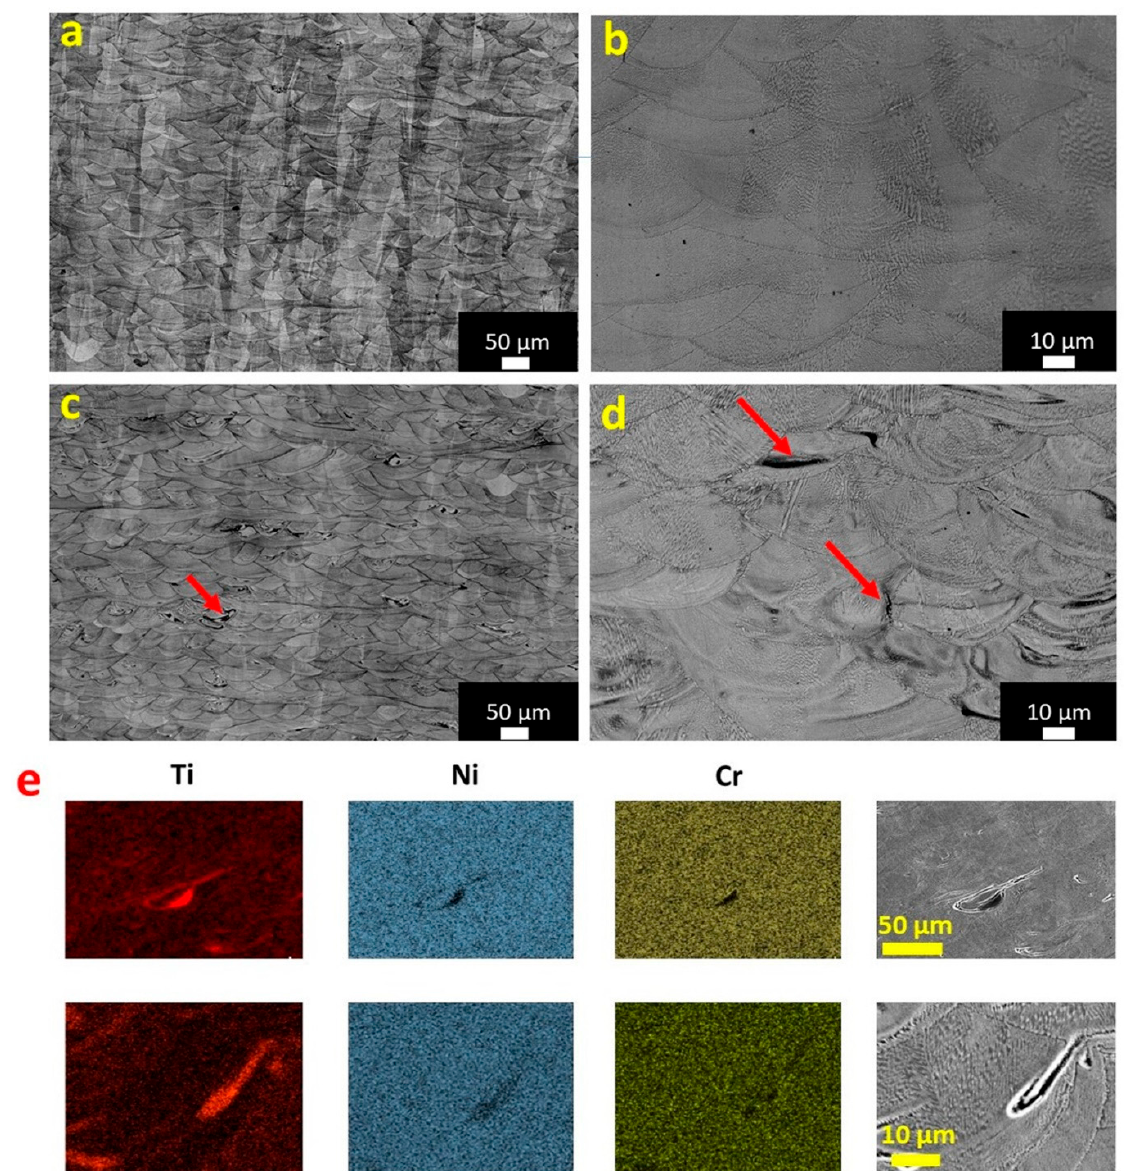
Figure 3. LOM images of the AB IN625 ( a , b ) and AB IN625mod ( c , d ). Presence of residual Ti-rich segregations (indicated by the red arrows) in the AB IN625mod version. EDS maps of the AB IN625mod ( e ) revealing the zones with Ti-rich segregations along the melt pool